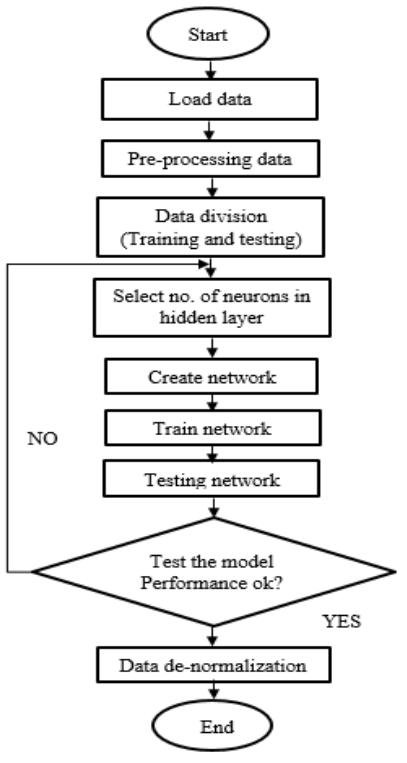
Figure 5. Feed-Forward Neural Network (FFNN) procedure.